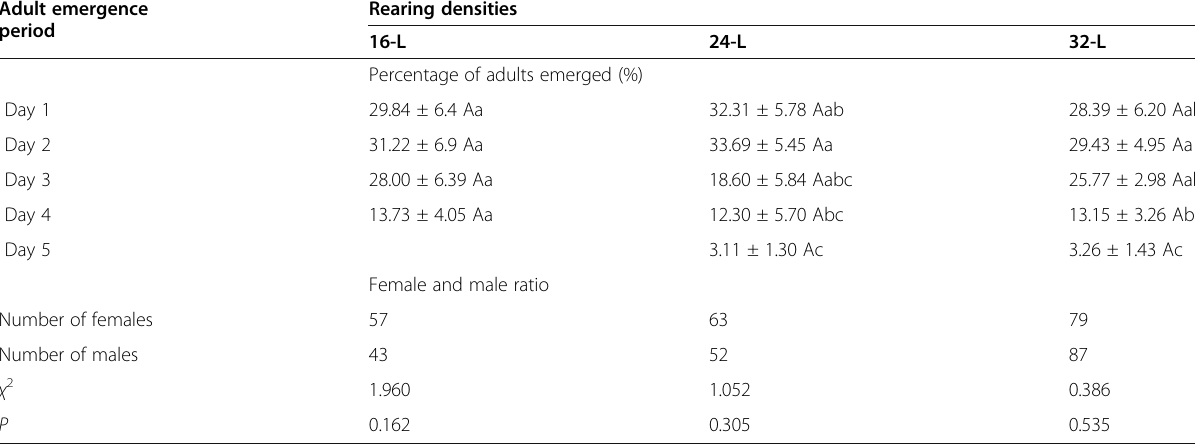
Different lowercase letters indicate significant differences in the percentages of adults emerged at different days; same uppercase letters indicate no significant difference among different rearing densities at each adult emergence period ( P <